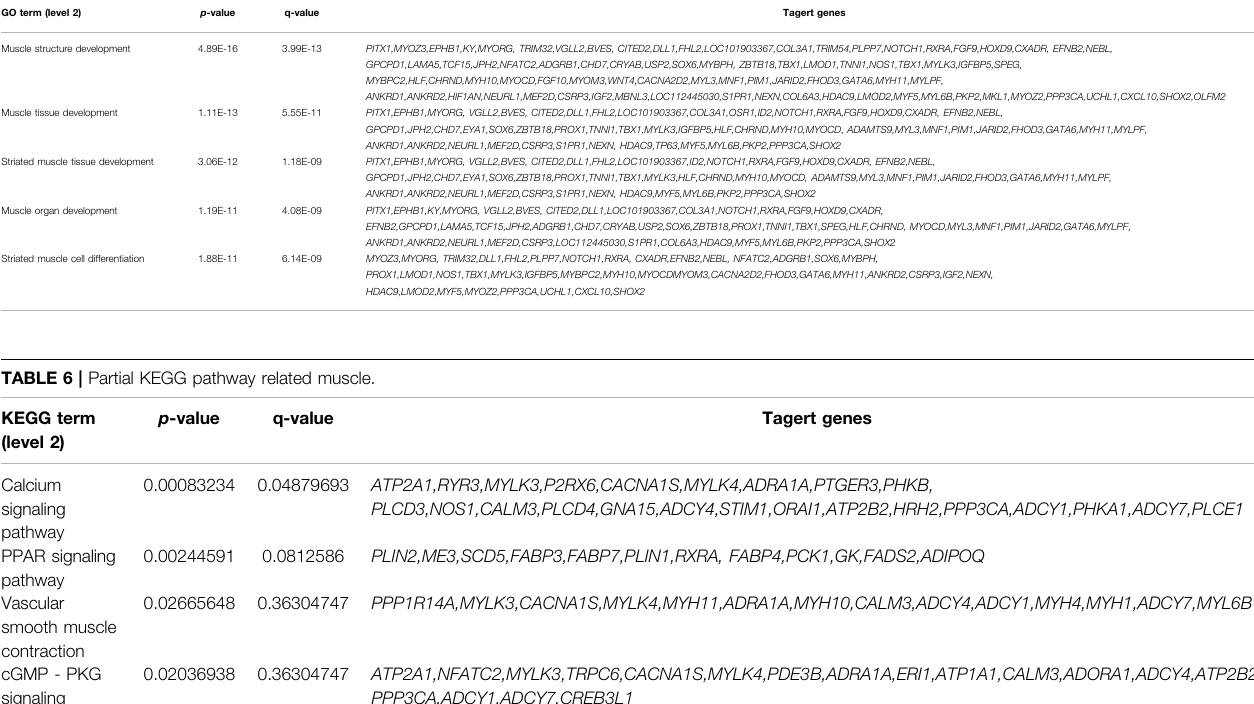
TABLE 5 | Partial GO term related